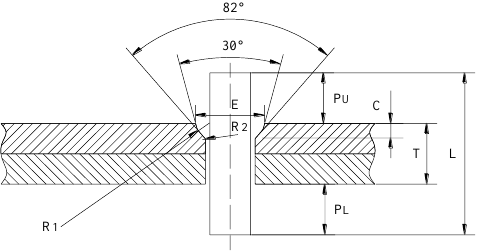
Figure 1. The structural sketch of a riveted lap joint.